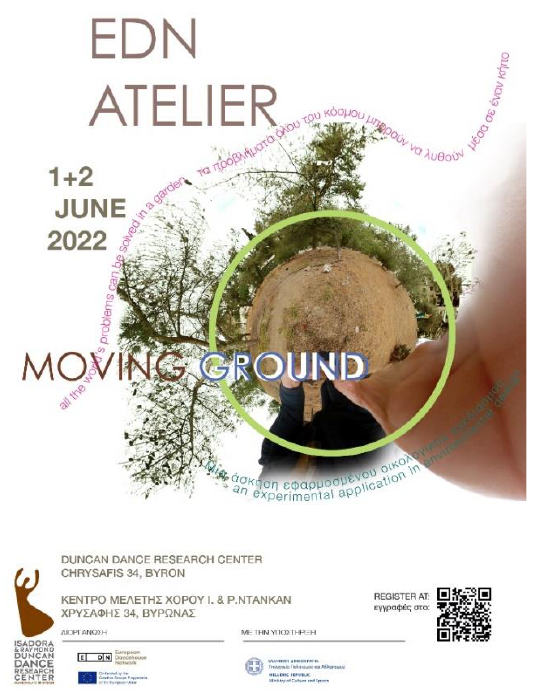
Figure 6. Poster for the EDN Atelier two-day event, 1 and 2 June 2022. Design: Dimitris The-